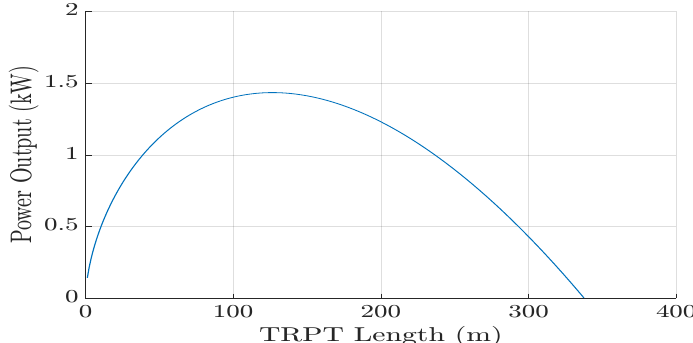
Figure 30. Power output for the optimised Daisy Kite rotor for different TRPT